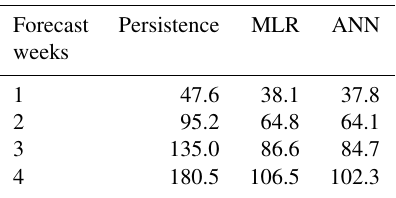
Table 4. Comparison of the mean forecast distance errors (km) of the persistence, multiple linear regression (MLR), and artificial neu- ral network (ANN)